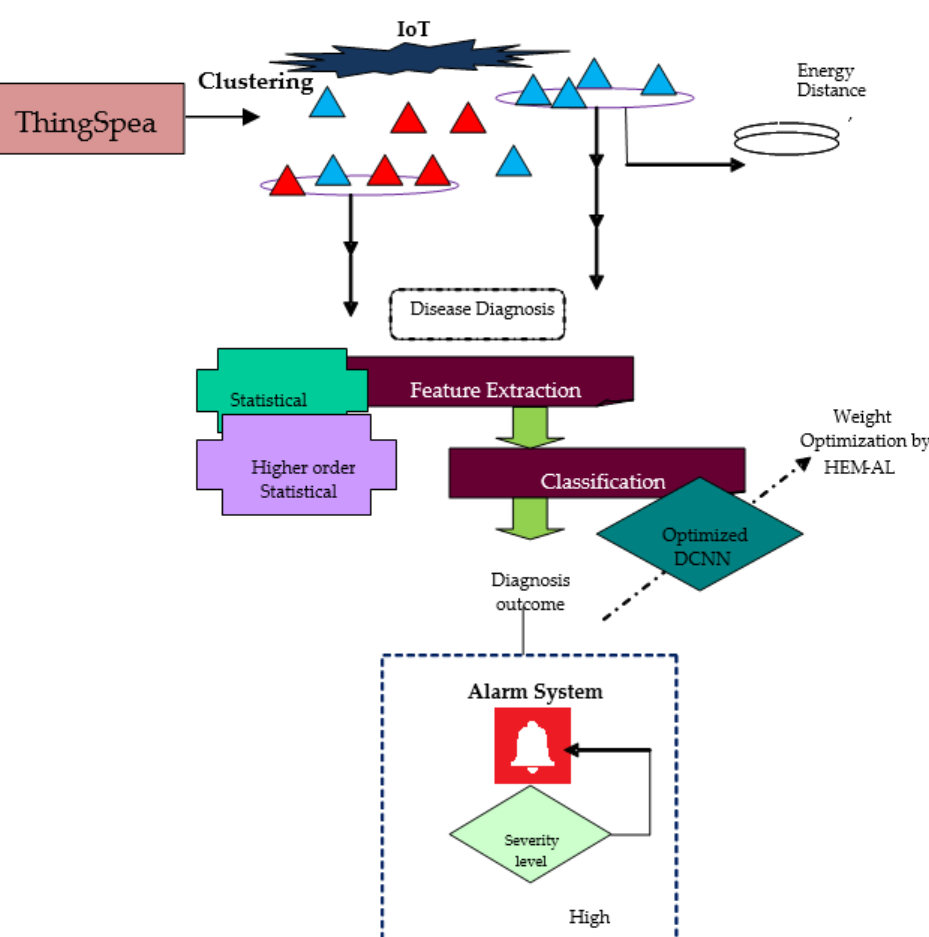
Figure 1. Schematized representation of the proposed framework.